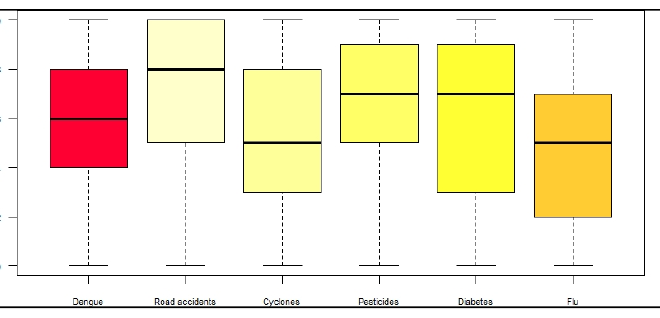
Figure 4. Degree of concern about dengue regarding other potential risks.